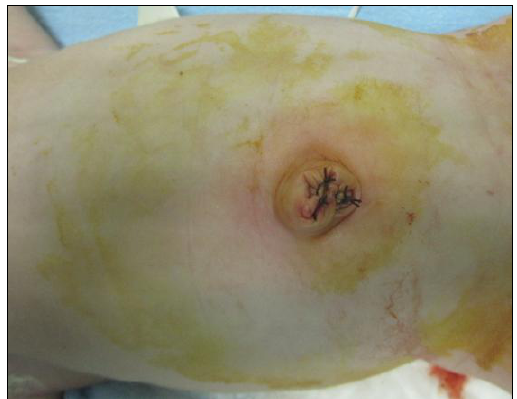
Figure 2: After bedside